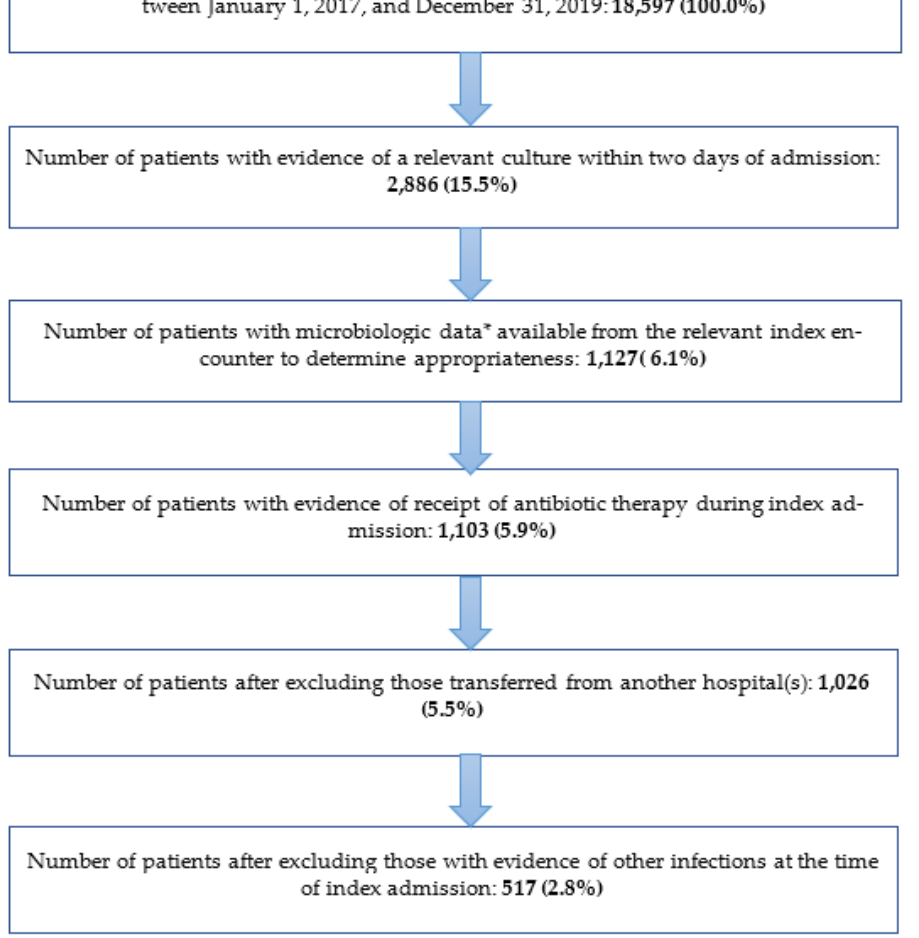
Figure 1. Patient attrition. Abbreviations: NA = not available. * Microbiologic data available in Premier included pathogens identified in culture draw and susceptibilities to various antibiotics, specimen source, and specific test utilized by the facility. Note: Zero (0) patients died on the day of index admission, were discharged on the same day as index admission, or had evidence of a condition related to pregnancy or childbirth during the time of index